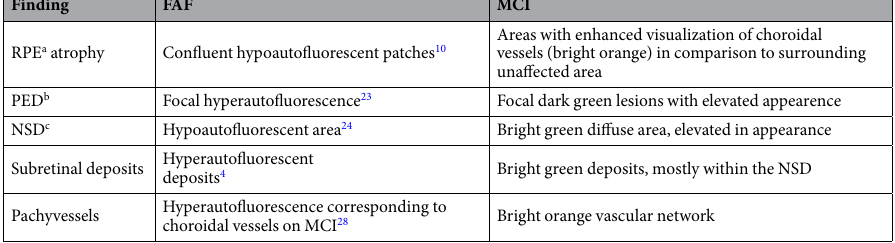
Table 1. Imaging features of five clinical findings in central serous chorioretinopathy(CSCR) on fundus autofluorescence (FAF) and rmulticolor imaging (MCI). a Retinal pigment epithelium. b Pigment epithelial detachment. c Neurosensory detachment.